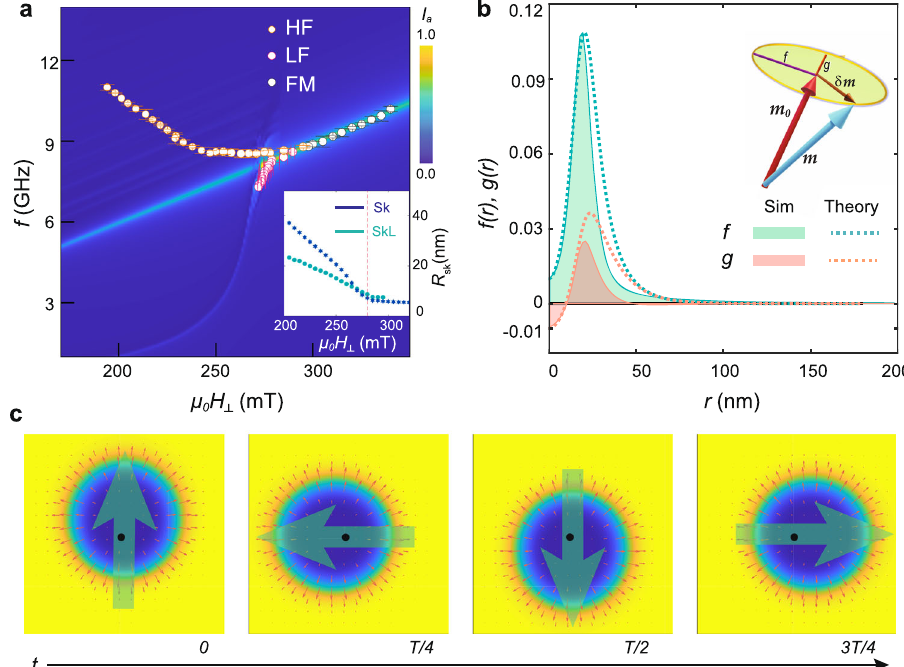
Fig. 4 Single-skyrmion simulations exposing the counterclockwise (CCW) nature of the LF resonance. Micromagnetic simulations were performed on a prepared metastable state of area 1 × 1 μ m 2 consisting of a single skyrmion in a fi eld-polarised background. a Simulated absorption intensity obtained from the Fourier transform of the in-plane magnetisation m x ( t ) after excitation by an in-plane sinc pulse with amplitude b 0 = 2 mT. The overlaid symbols show our experimental data for comparison. The inset depicts the fi eld-dependent radius of the isolated skyrmion (Sk) compared with the skyrmion radius in the regular lattice (SkL), discussed in Fig. 5. The red dashed line at μ 0 H ⊥ = 280 mT marks the onset of the LF resonance identi fi ed as a CCW magnon-skyrmion bound state. b Spin wave eigenfunctions f ( r ), g ( r ) of the CCW resonance at μ 0 H ⊥ = 250 mT, respectively parametrised by the semi-major and semi-minor axes of the precessional ellipse of the local magnetisation. Our numerical data (Sim) is compared to an analytical approximation (Theory). c Temporal evolution of the CCW skyrmion resonance at μ 0 H ⊥ = 250 mT with oscillation period T = 345 ps, where the large green arrow represents the total dipole moment. The black dot represents the stationary centre de fi ned by the fi rst moment of the topological charge density ρ the displayed area is 78 × 78 nm 2